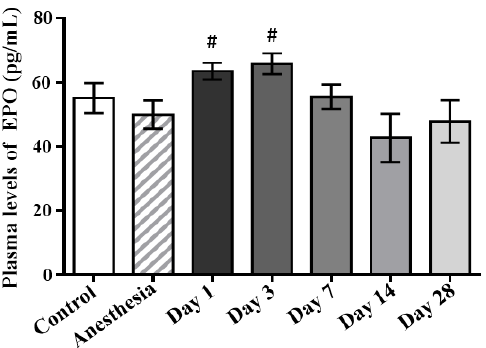
Figure 9. Plasma erythropoietin levels in control and irradiated rats measured on the 1st, 3rd, 7th, 14th, and 28th days after irradiation. # p < 0.05 (compared to anesthesia).